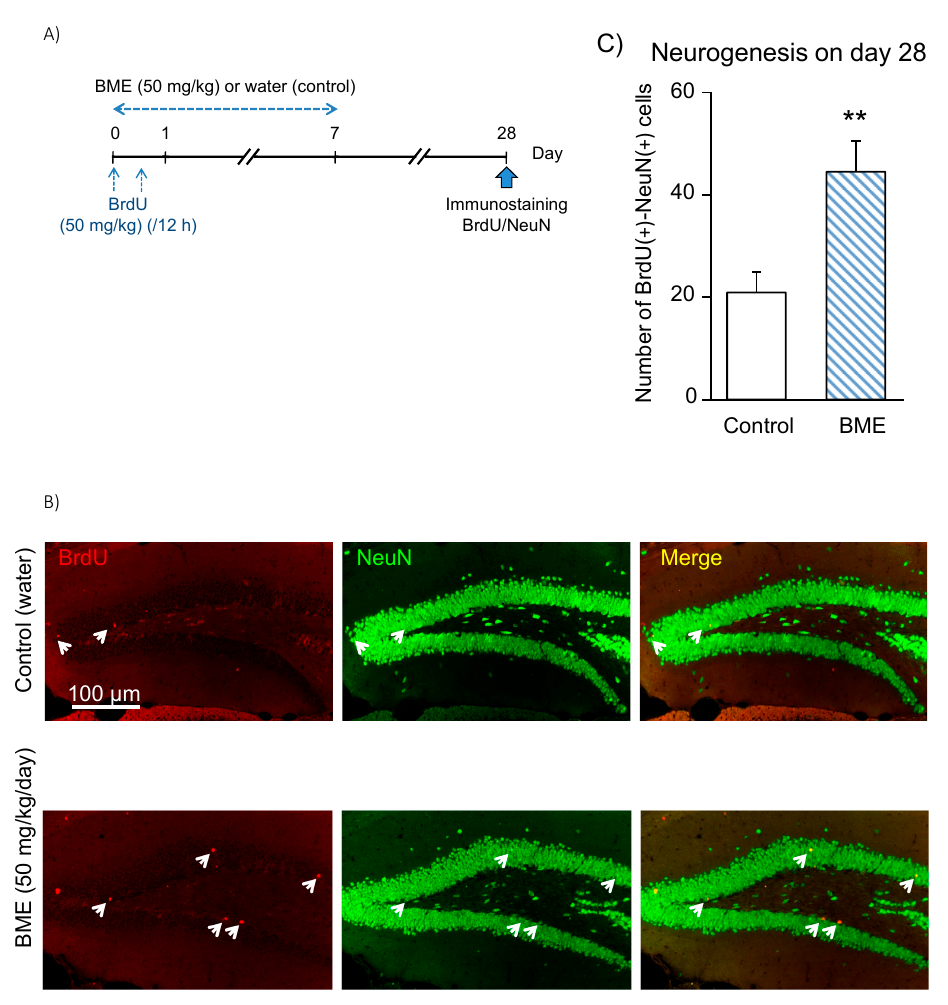
Figure4. E ff ectofBMEonneuronaldi ff erentiationofBrdU( + )cellsin5-week-oldmice. ( A )Experimental schedule. Animals were given either BME (50 mg / kg, p.o) or water for 7 consecutive days, and all animals received BrdU (50 mg / kg, i.p.) with a 12-h interval on the first day of the experiment and were then decapitated on day 28 post-treatment to prepare sagittal hippocampal sections. The sections were immunostained with antibodies for BrdU and NeuN. ( B ) Fluorescence micrographs of NeuN( + ) cells (green) and BrdU( + ) cells (red) in the dentate gyrus of the water- and BME-treated groups. White arrows indicate BrdU-NeuN double-positive cells. ( C ) Neurogenesis detected in the GCL ± SGZ of dentate gyrus on day 28 after 7-day treatment with BME. Each data column represents the mean ± SEM, calculated from four animals in each group. ** p < 0.01 compared to water-treated